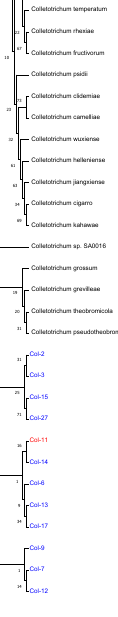
Figure 8. Multi-locus sequence analysis based on five genomic regions ( TUB, CHS, ITS , ACT and GAPDH ) amplified from different isolates of Colletotrichum obtained from pomegranate in India and reference isolates of diverse species belonging to the Colletotrichum gloeosporioides species complex. The Maximum Likelihood (ML) tree was drawn using MEGA XI with 1000 bootstraps. Isolates in red belong to morphotype I, while those in blue to morphotype